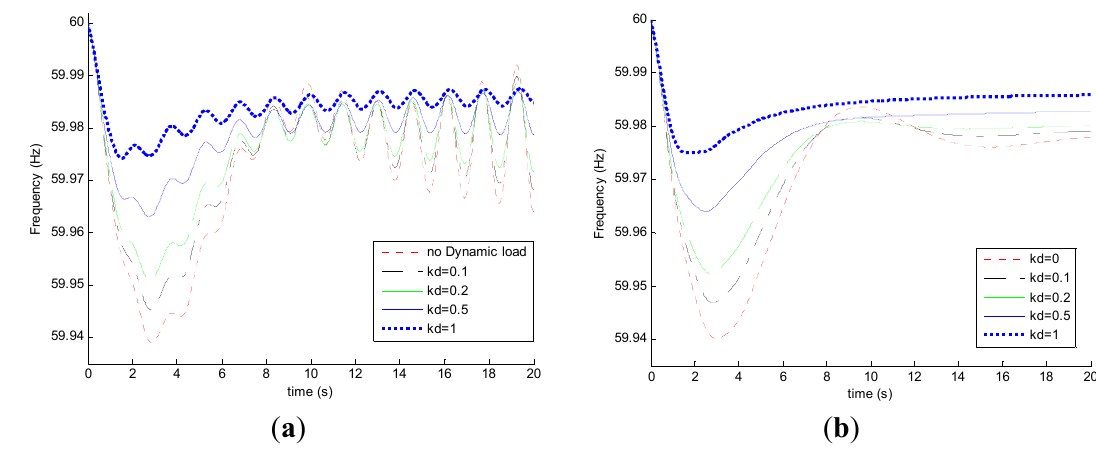
Figure 5. Comparisons of the frequency deviations under different dynamic load characteristics in a small disturbance. ( a ) No DFC; ( b ) with